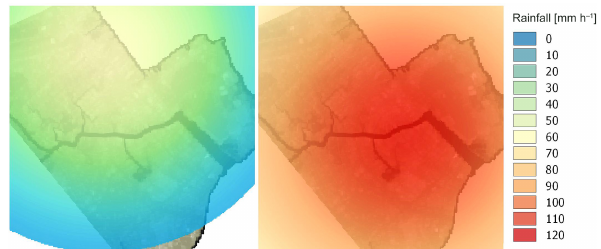
Figure 10. Examples of synthetic hourly rainfall events for an- nual probability of non-exceedance p = 0.5 (left panel) and annual probability of non-exceedance p = 0.99 (right panel). Note that the storms have different randomly drawn storm centre